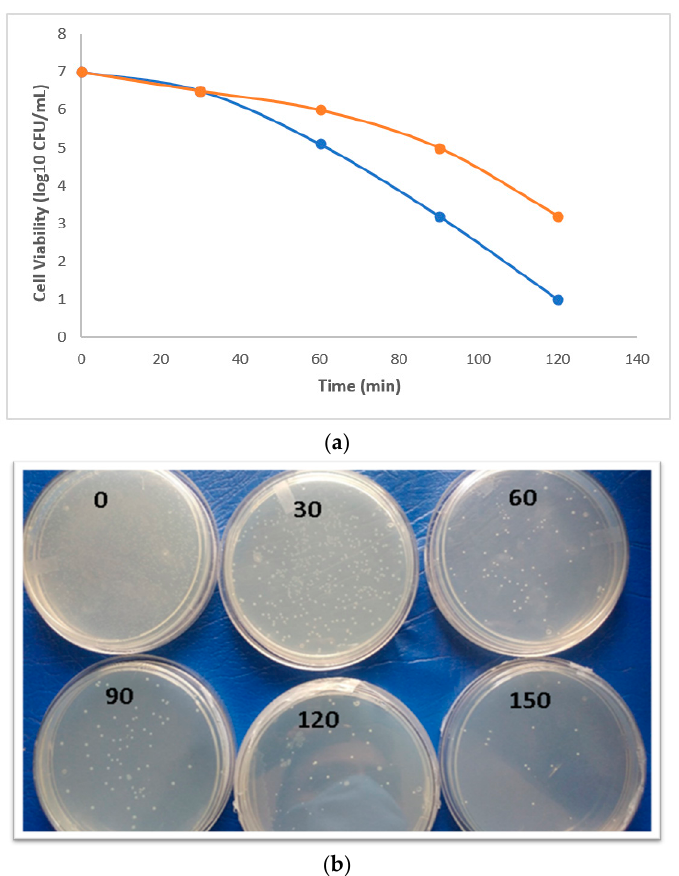
Figure 9. ( a ) Bacterial inhibition kinetics of Pd-Ag/rGO on E. coli K-12 in the presence of light (Blue line) and in the dark (Red line). ( b ) Bacterial inhibition performance of Pd-Ag/rGO on E. coli K-12 with light.